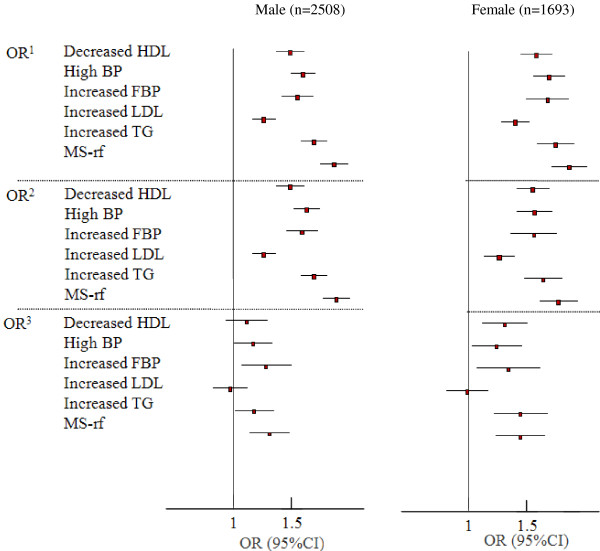
Gender-specific odds ratios (ORs) and 95% confidence intervals (95% CIs) of cardio-metabolic risk factors for neck circumference (NC). OR1: unadjusted, OR2: adjusted for age, OR3: adjusted for age, BMI, WC and WHpR.